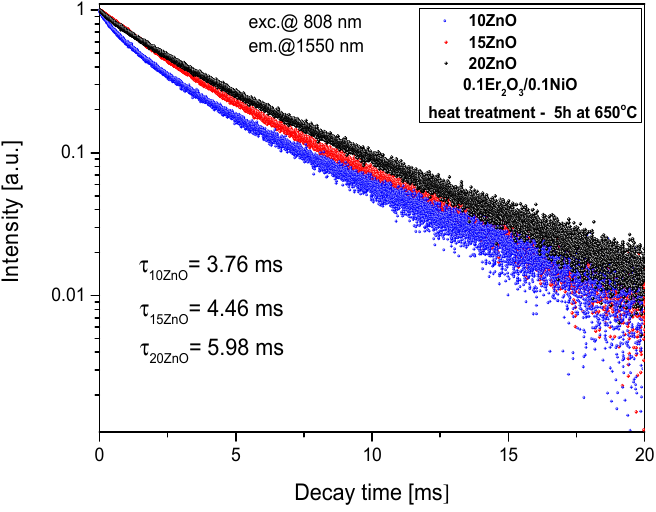
Figure 14. Luminescence decay curves from Er 3+ : 4 I 13/2 level in 5, 10, 15 ZnO glass-ceramics (HT@650 ◦ C for 5 h), λ exc = 808 nm.